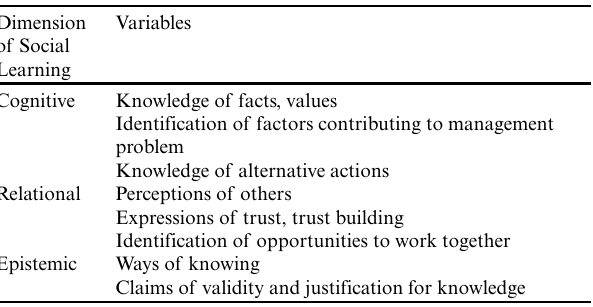
Table 1 . Common dimensions and variables of social learning to be applied in this investigation; drawn from Blackmore (2007), Muro and Jeffrey (2008,